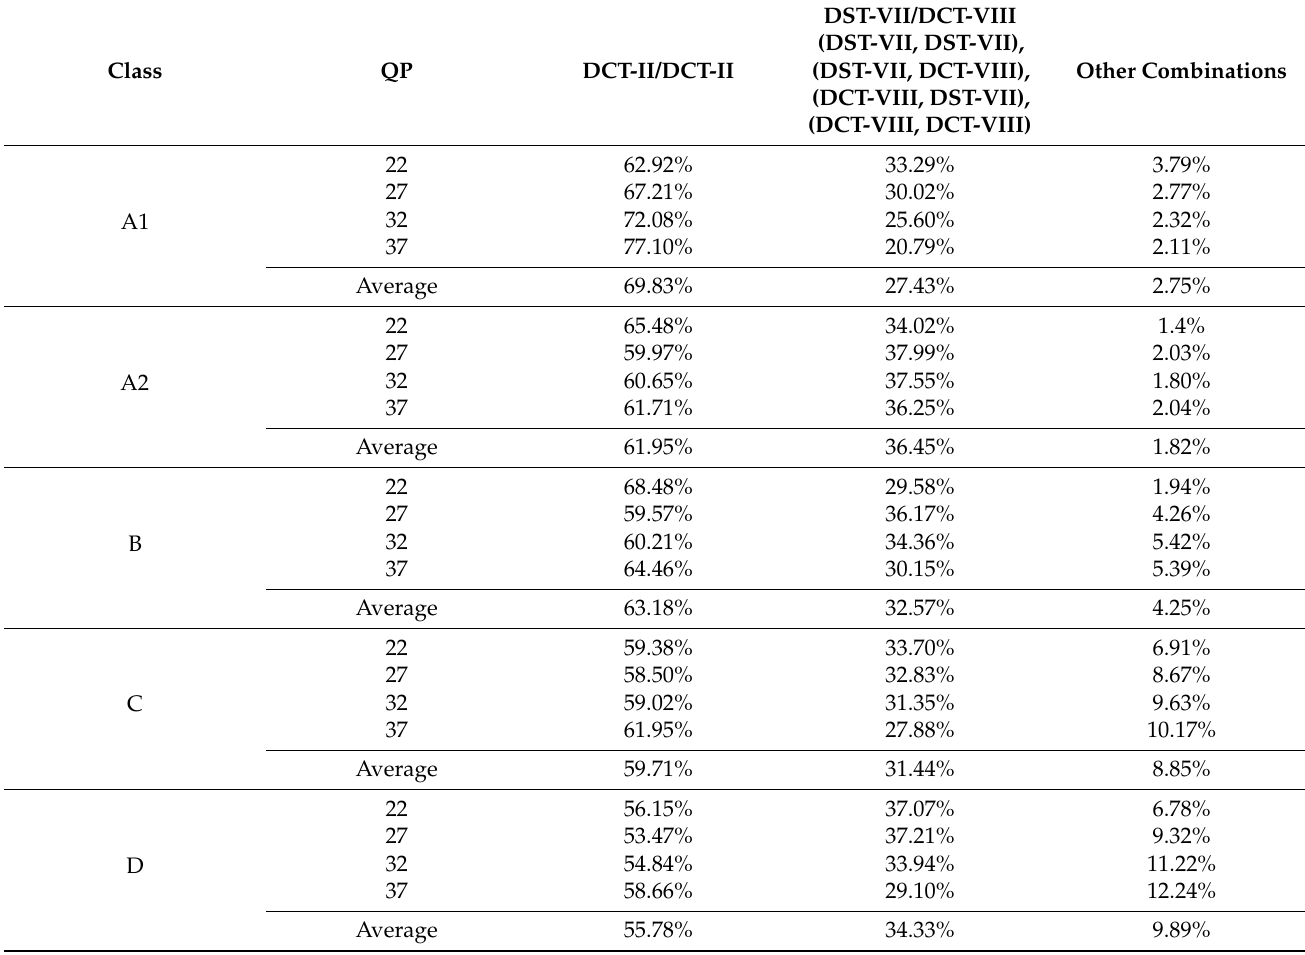
Table 5. Transform block percentage for each transform pair for the luma block.